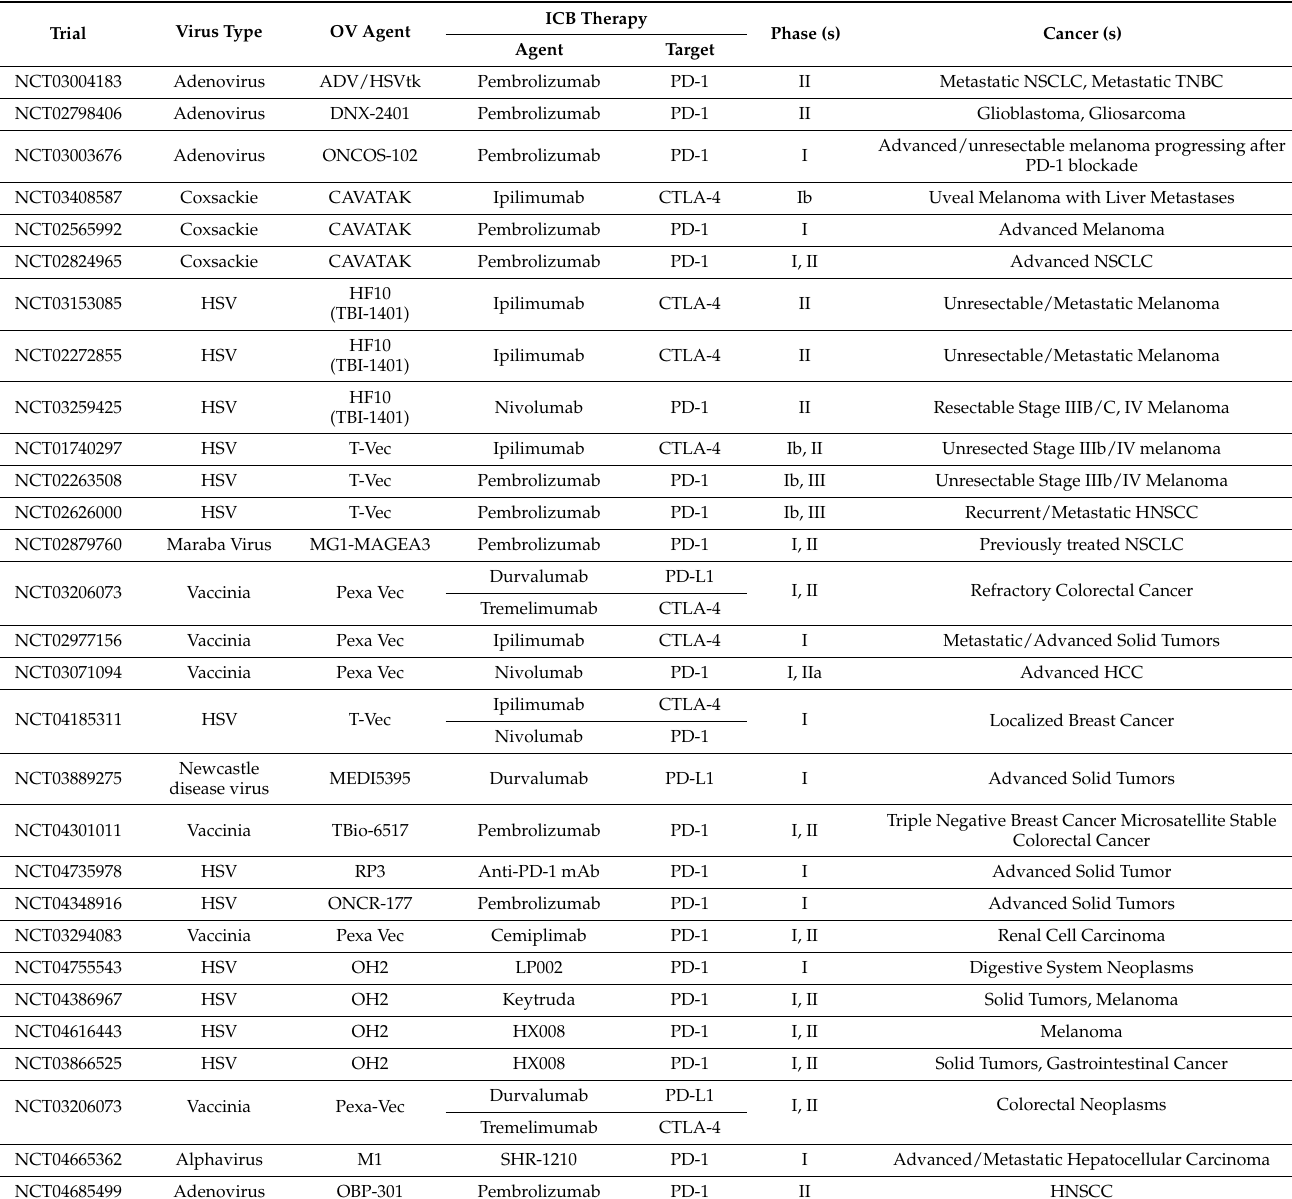
Table 3. List of clinical trials using OVs in combination with immune checkpoint blockade therapies for various cancers.